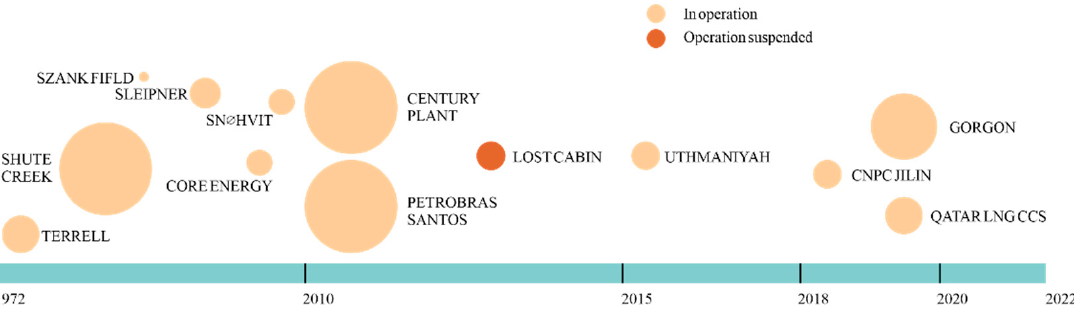
Figure 1. CCUS geological storage reuse project operations up to 2022 (size of circles represents injection size, modified from Global CCS Institute, 2022 [5]).